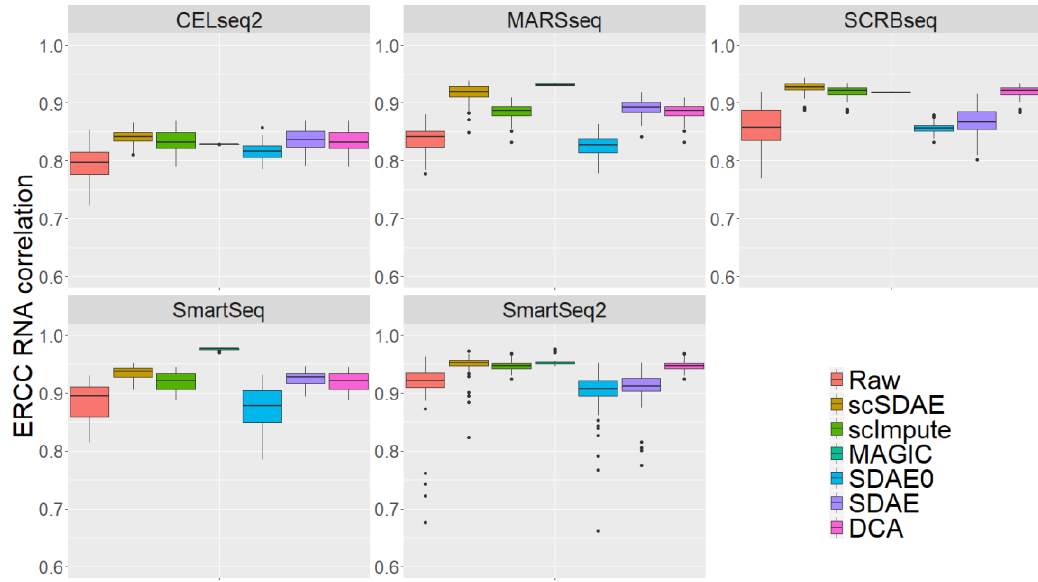
Figure 4. Boxplots of Pearson correlations between the imputed data and the known concentration of ERCC RNAs. Each panel represents a sequencing technique.